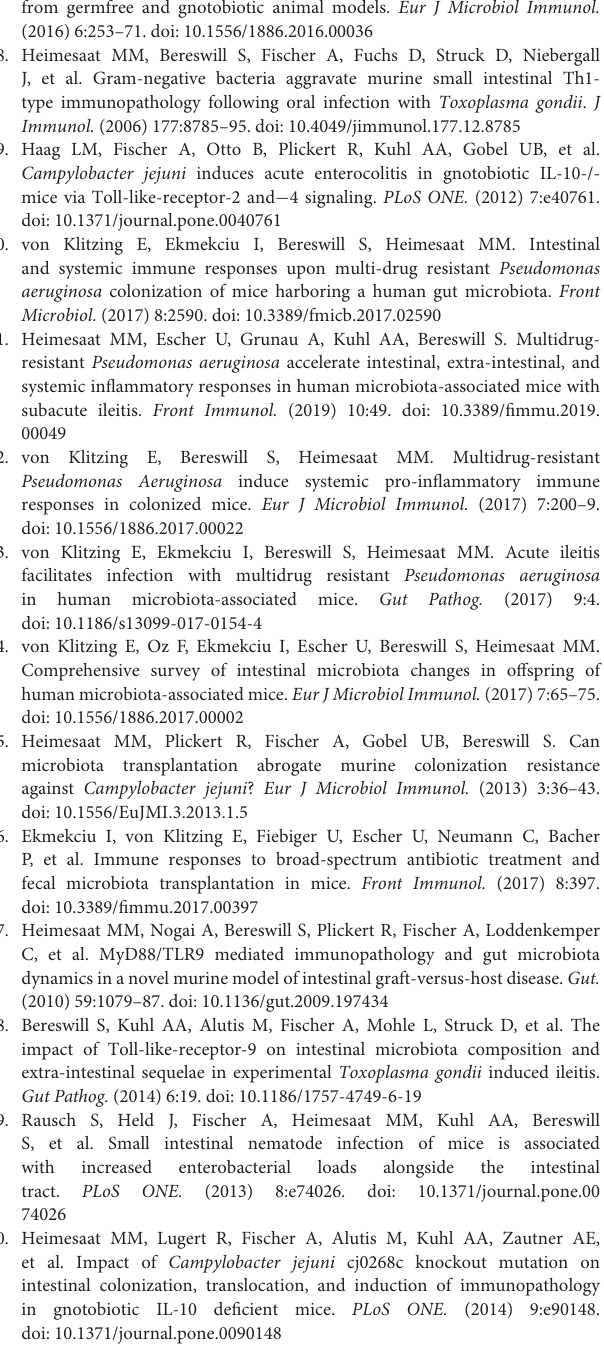
Figure S2 | Representative photomicrographs illustrating colonic apoptotic epithelial and immune cell responses following murine fecal microbiota transplantation in C. jejuni infected mice harboring a human gut microbiota. Mice with a human gut microbiota were perorally infected with C. jejuni on day (d) 0